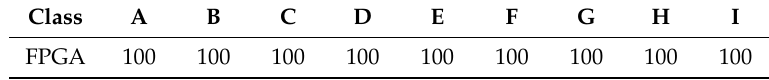
Table 6. Assessment of the introduced FPGA-based system for detecting and classifying PQDs.